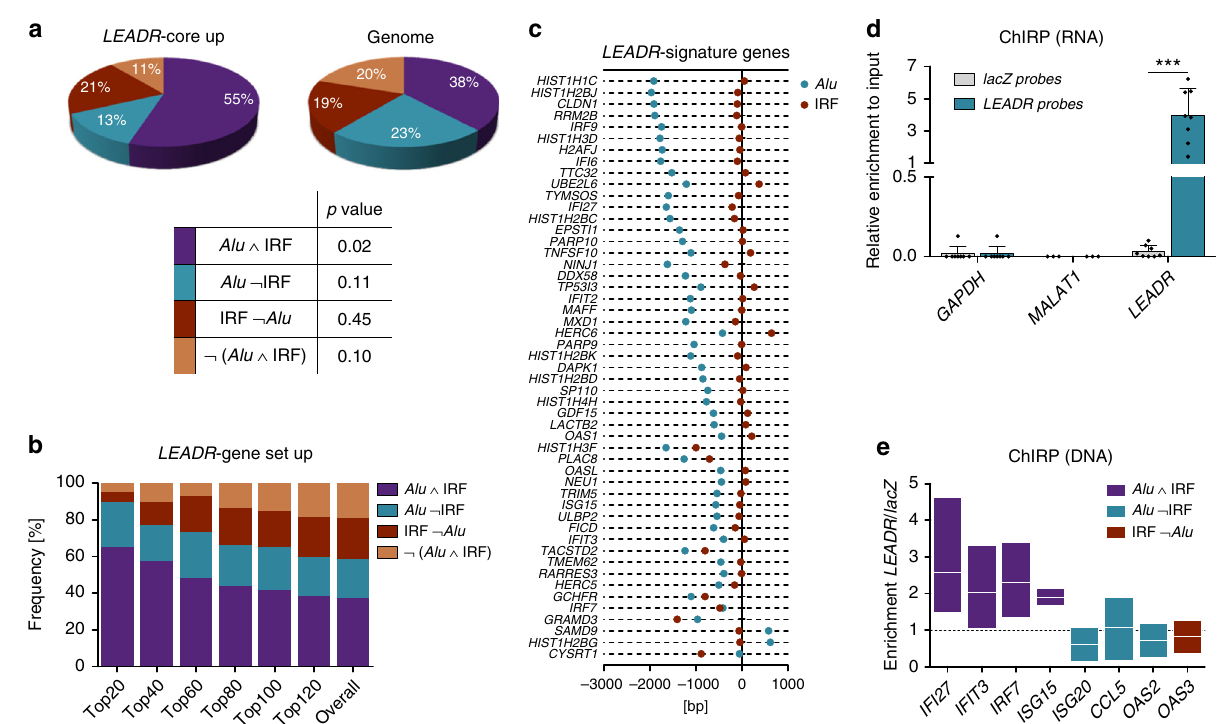
Fig. 8 LEADR physically binds to promoters of genes having Alu and IRF binding site motif in tandem. a Pie charts of the frequency of Alu /IRF sites in “ LEADR -core up ” genes and in genome ( top ). Table reporting hypergeometric test p value for each category is also depicted ( bottom ). b Bar plot of cumulative frequency of Alu /IRF sites in the promoters of “ LEADR- gene set up ” genes, ranked by mean of the FCs in LEADR KD experiments. c Reciprocal positioning of Alu /IRF sites in promoters of “ LEADR -signature ” genes. Genes depicted in the transcription direction, with TSS set to zero. d qRT-PCR showing RNA retrieval upon ChIRP performed in RWPE-1 cells using probes complementary to LEADR or to lacZ . Mean + s.d. plotted. e ChIRP-qPCR detection of LEADR occupancy on representative target loci (normalized to unrelated genomic region) in RWPE-1 cells. Line at mean plotted ( n = 3). Source data are provided as a Source Data fi le, together with n of all